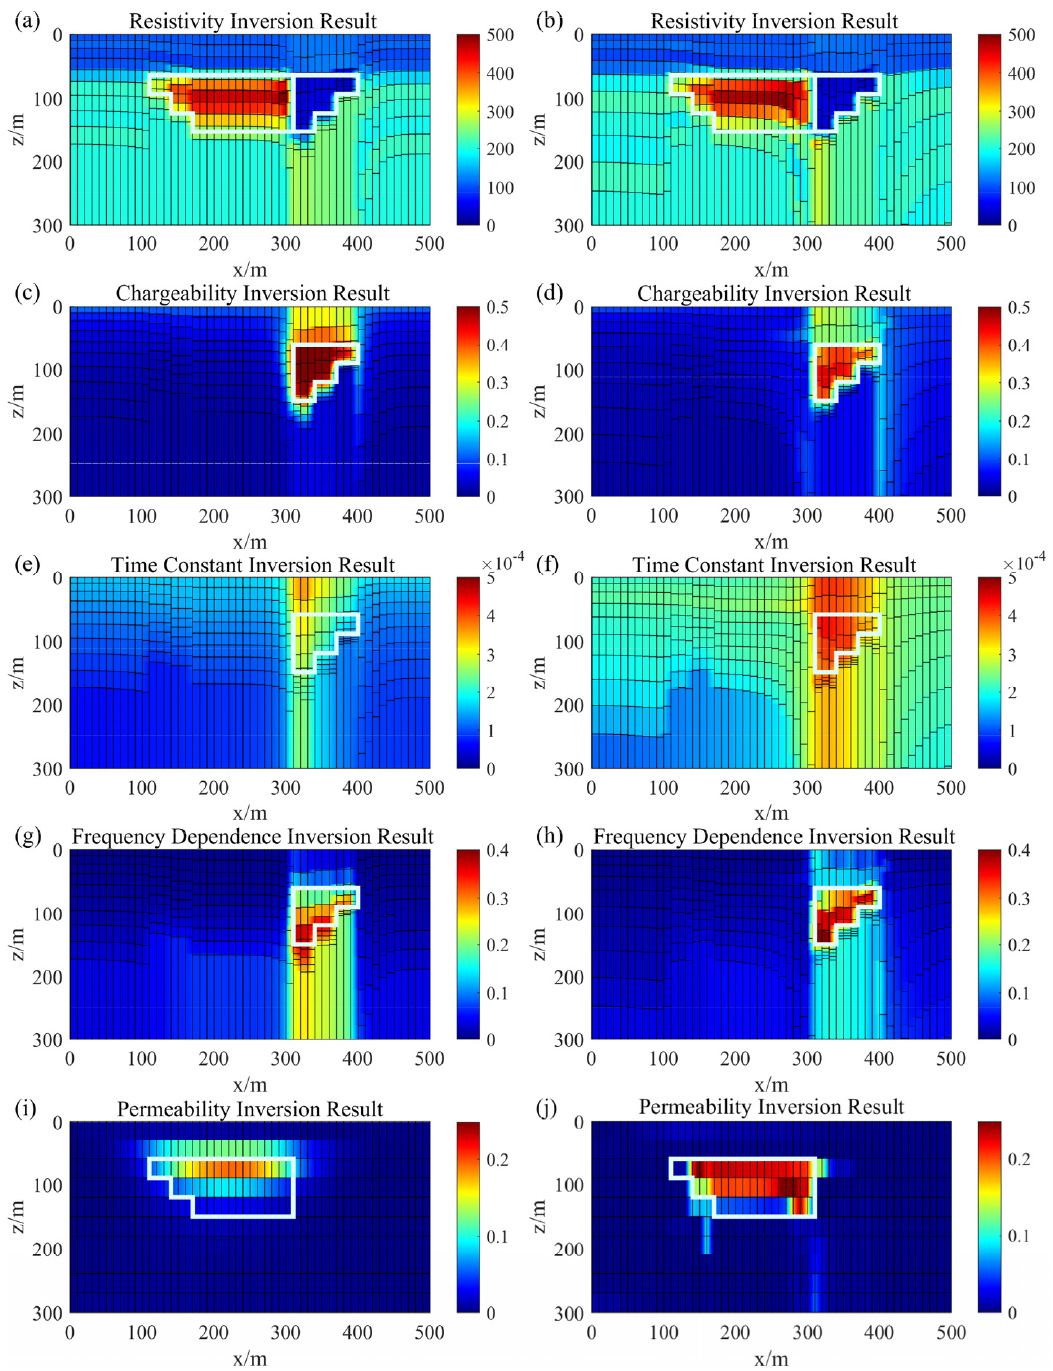
Figure 14. Comparison of model 2’s conventional inversion and cooperative inversion results: ( a , c , e , g , i ) conventional inversion findings; ( b , d , f , h , j ) cooperative inversion